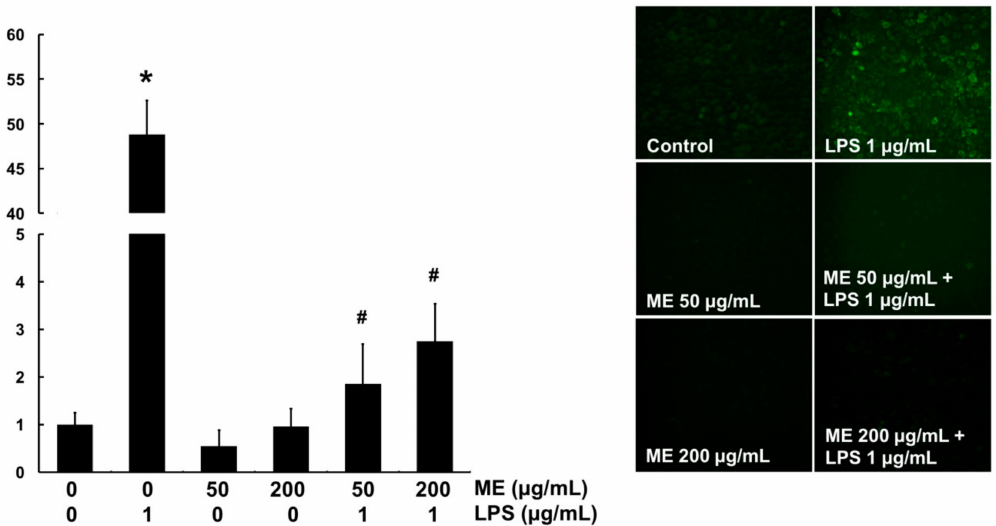
Figure 5. Intracellular ROS scavenging activity of moringa extract (ME). Cells were treated with ME for 12 h and then stimulated with LPS for 4 h. Cells were then stained with DCF-DA to detect ROS production. The intensity of green fluorescence was assessed using a fluorescence microscope at 200 × magnification. Images shown are representatives of three independent experiments. Values represent means ± SEM ( n = 3). *, significant di ff erence vs. control ( p < 0.05). #, significant di ff erence vs. LPS only ( p <